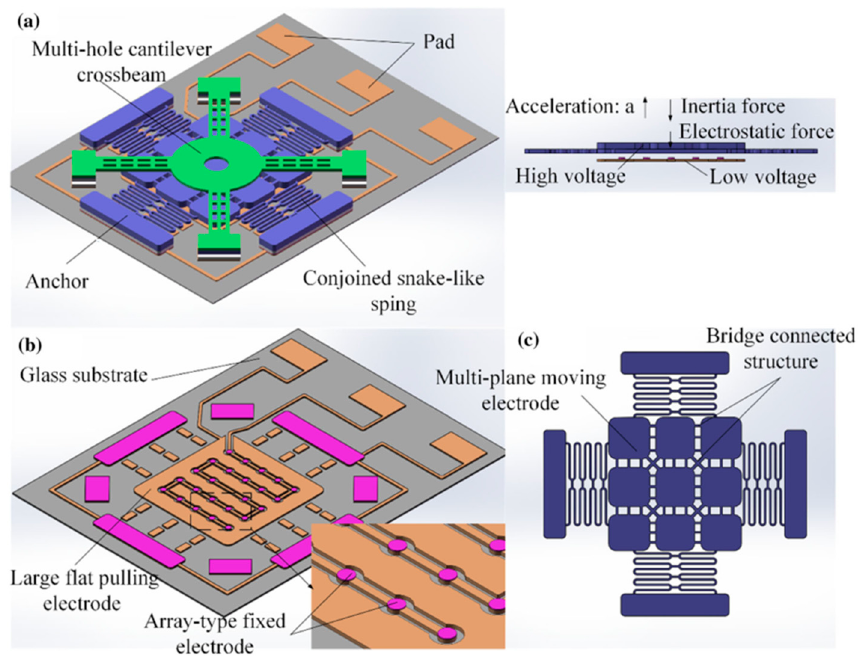
Figure 12. ( a ) Sketch of an electrostatic force-assisted contact-enhanced MEMS (micro-electro-mechanical system) inertial switch. ( b ) Schematic of the array-type fixed electrode and pulling electrode, and ( c ) top view of the moving electrode [64].